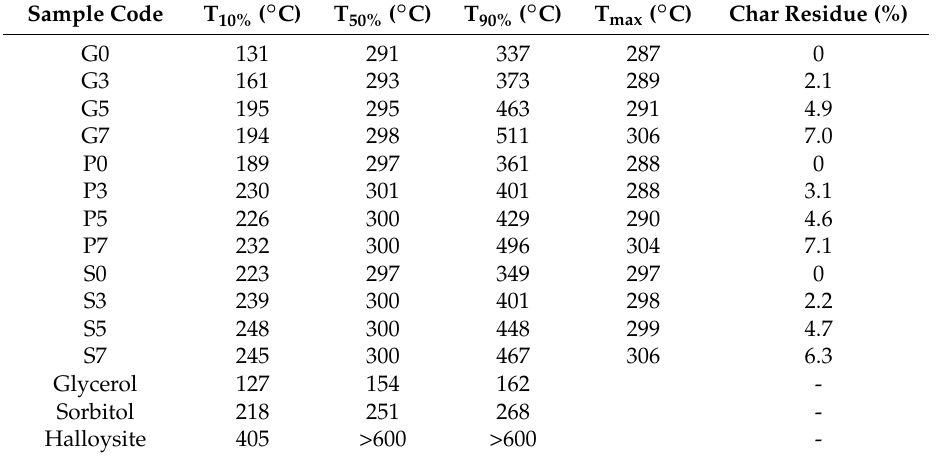
Table 1. TGA data for the starch-based nanocomposites and neat glycerol, sorbitol and halloysite. Sample